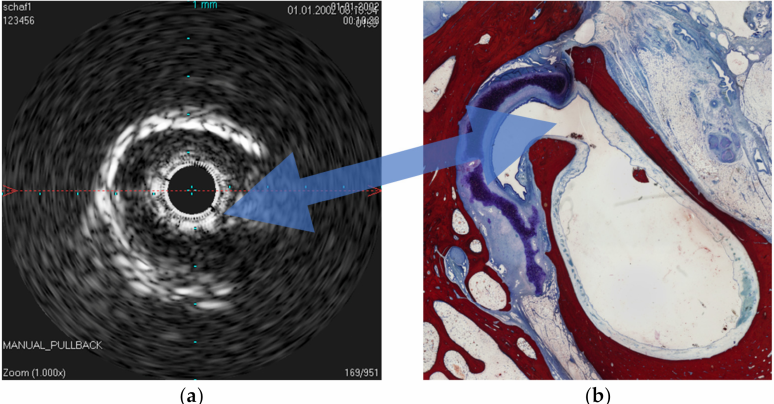
Figure 2. Comparison of the sonographic cross-sectional image in the area of the ET isthmus with the histology. ( a ) Sonographic cross-sectional image of the ET lumen in the area of the isthmus.